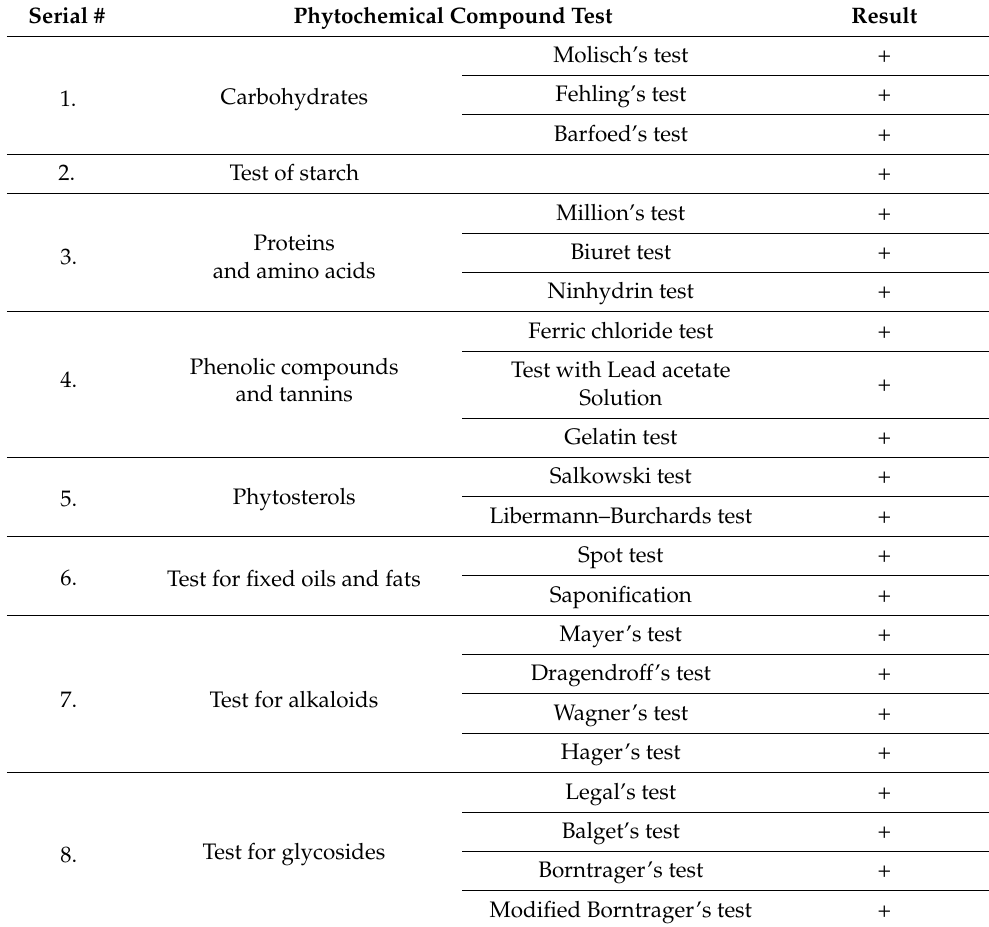
Table 1. Phytochemical analysis of aqueous leaf